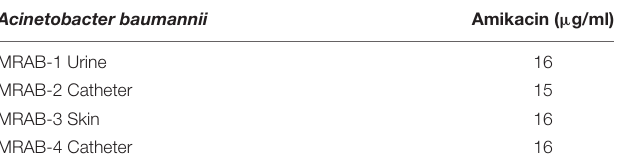
TABLE 3 | Minimum biofilm inhibitory concentration (MBC) of multidrug resistant isolates of Acinetobacter baumannii (MRAB) in the presence of